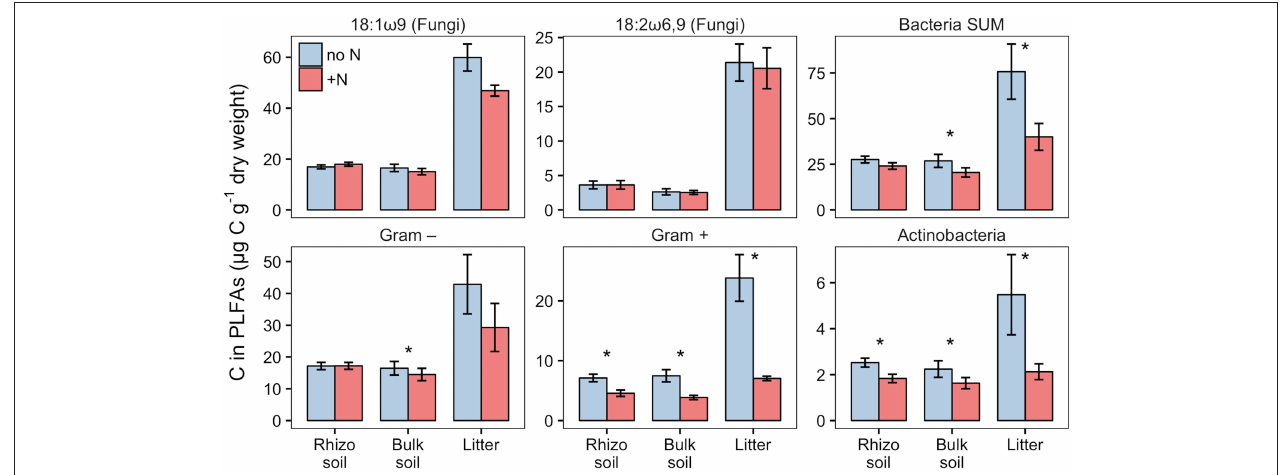
FIGURE 8 | Biomass of fungi and bacterial groups in rhizosphere, bulk soil and litter pools of N-treated and untreated sides of dual-labeled ( 13 C and 15 N) plant boxes, represented by PLFA biomarkers. Biomass of Actinobacteria and Gram-positive bacteria (excluding the Actinobacterial PLFA) declined significantly in both litter and soil compartments with N addition (i.e., to the litter compartment). Significant differences between N-treated ( + N) and untreated side (no N) are indicated with asterisks (Mann-Whitney U -test for paired samples; p < 0.05; n = 6). Although not statistically significant, the adverse effect of N addition is also present in Gram-negative bacteria in litter, and the fungal PLFA 18:1 ω 9 in litter and bulk soil ( p < 0.01). Error bars represent the standard error. Differences between soil and litter pools of the untreated side were analyzed with the Kruskal-Wallis rank sum test. Significant test results ( p < 0.05) were followed by Dunn’s post-hoc test of multiple